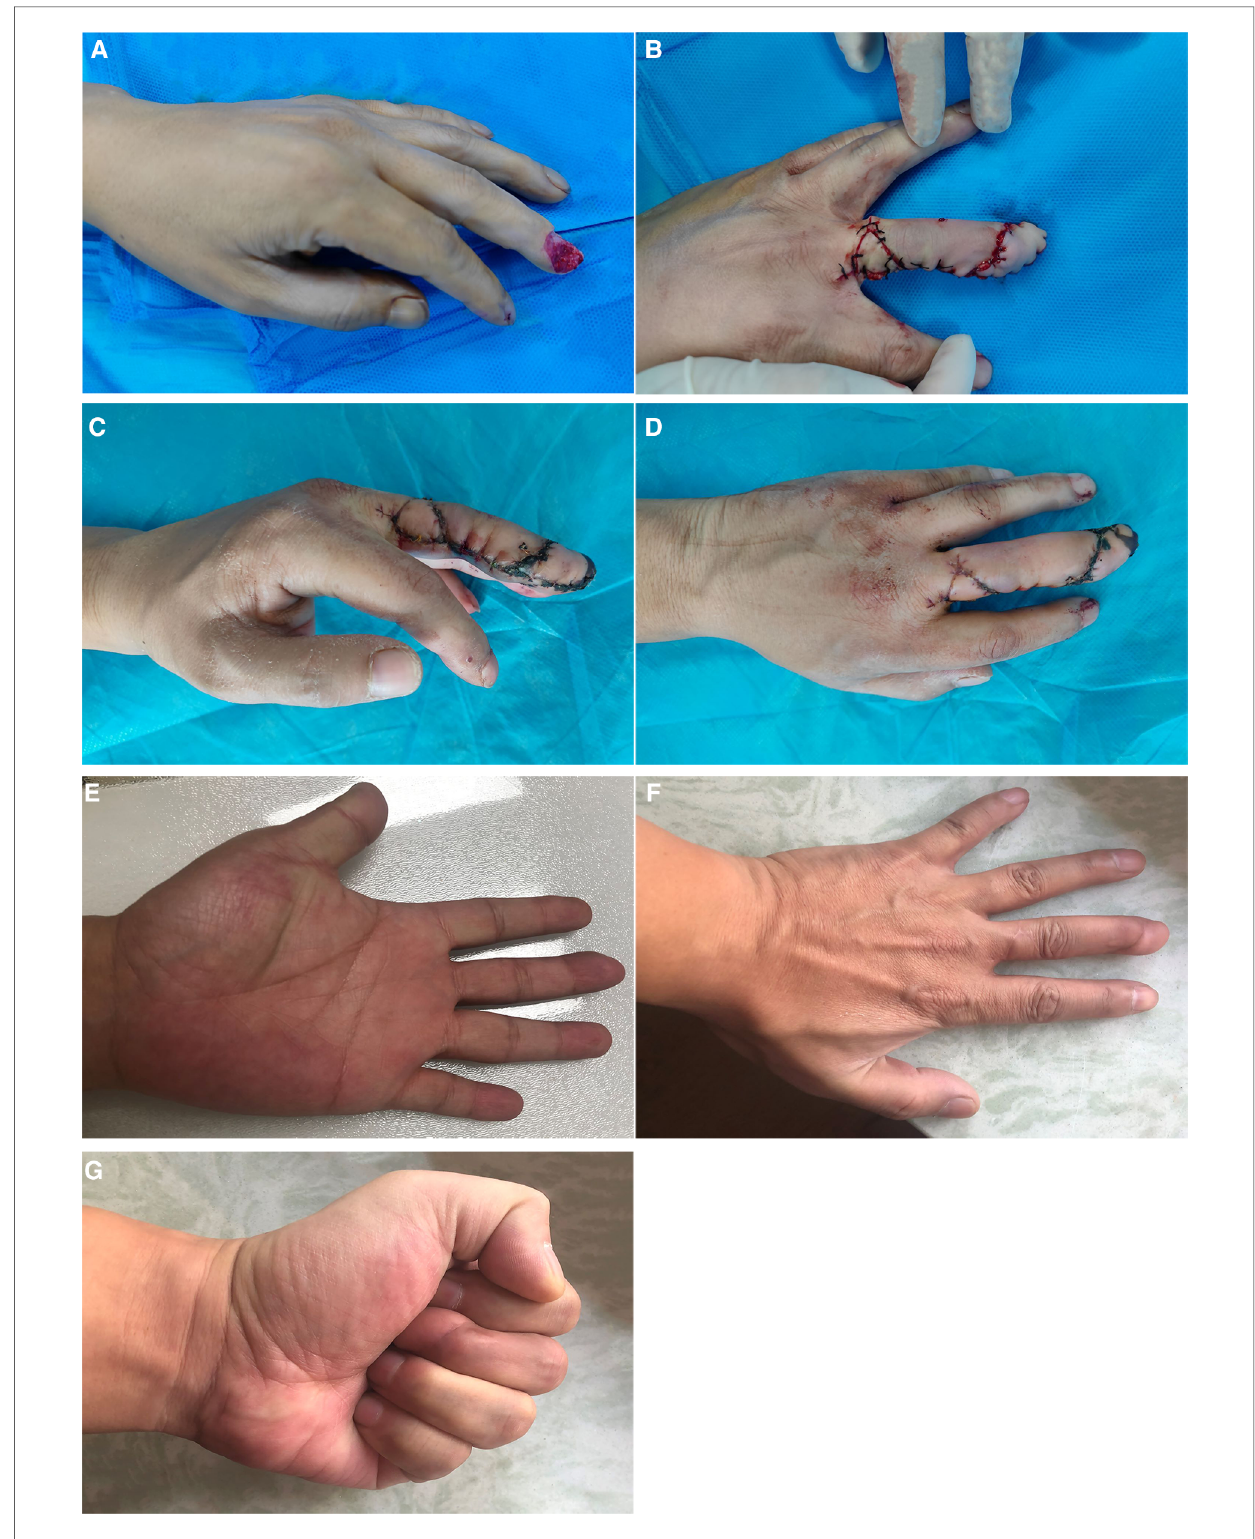
FIGURE 2 Case: 10 ( A ) Skin and soft tissue defect on the fi ngertip of the left middle fi nger. ( B ) The defect of fi ngertip was repaired by digital artery island fl ap, and a digital dorsal advancement fl ap was used to cover the donor site. ( C,D ) The incision healed well and the fl ap survived completely after two weeks of operation. ( E – G ) A 11-month follow-up after the